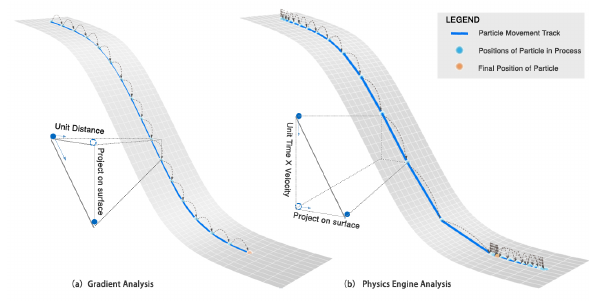
Figure 1. Comparison of Gradient Analysis and Physics Engine simulation